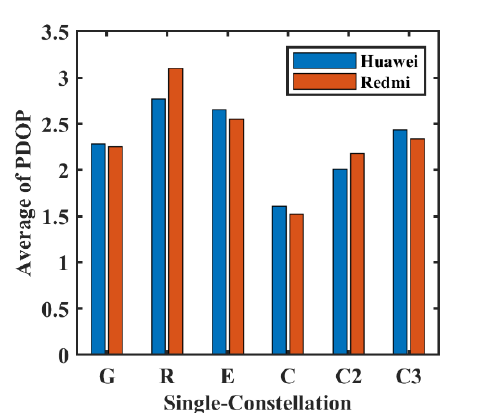
Figure 14. The average PDOP for single-constellation in velocity